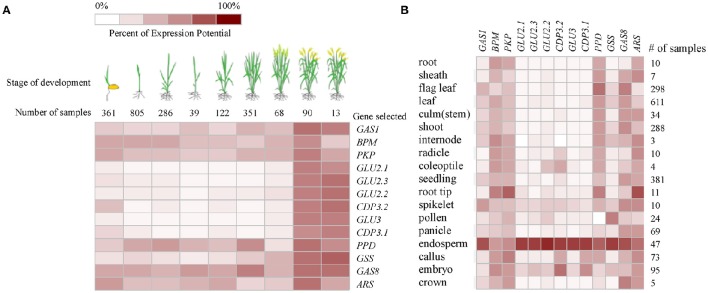
Expression pattern of genes encoding the identified proteins in various developmental stages (A) and tissues (B) of rice based on the publicly available microarray data (http://www.genevestigator.com).